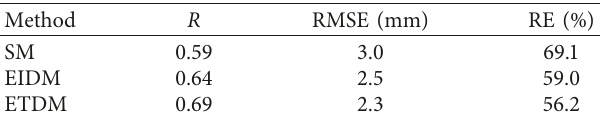
Table 2: Statistics of correlation coefficient ( R ), root-mean-squared error (RMSE), and relative error (RE) that evaluate the perfor- mance of the three methods to derive RQPE during April to June